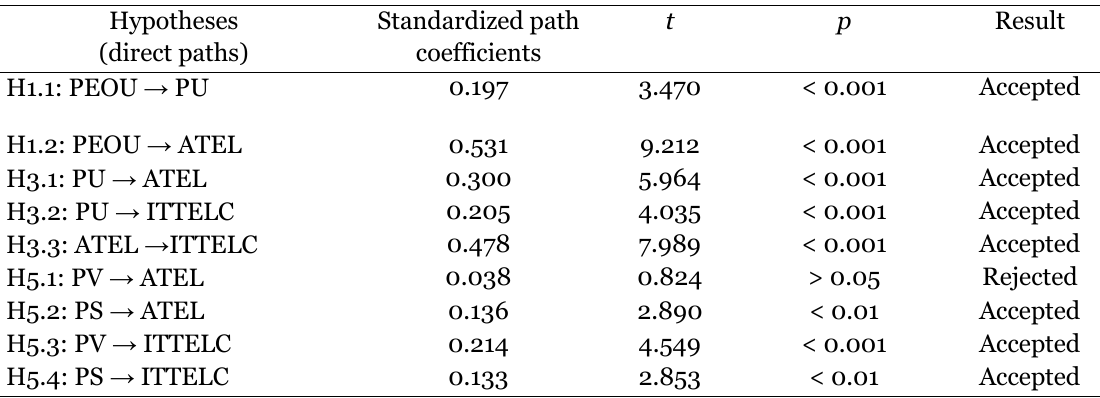
Table 5 Results of Hypothesis Testing for Direct